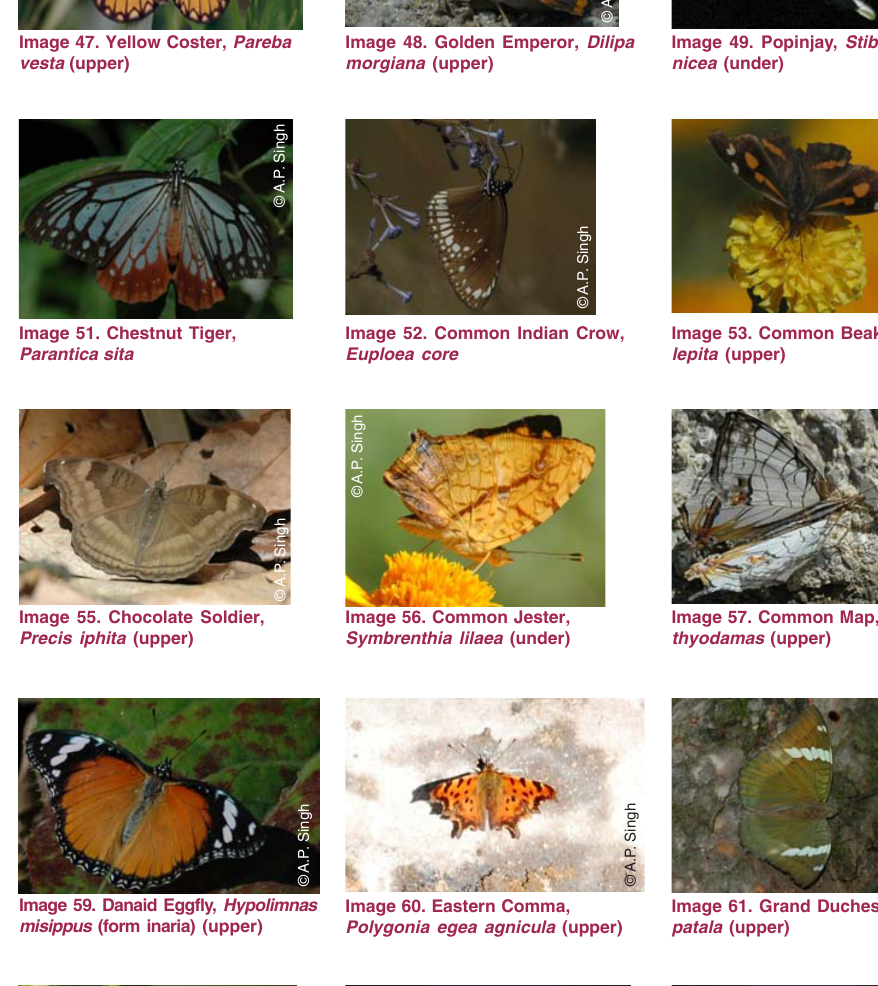
Image 48. Golden Emperor, Dilipa morgiana (upper)